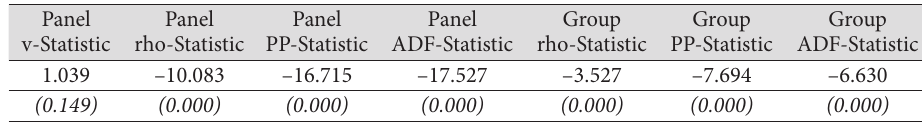
Table 13. Panel co-integration tests (long term variables of NCI equation) Panel Panel Panel Panel Group Group Group v-Statistic rho-Statistic PP-Statistic ADF-Statistic rho-Statistic PP-Statistic ADF-Statistic 1.039 –10.083 –16.715 –17.527 –6.630